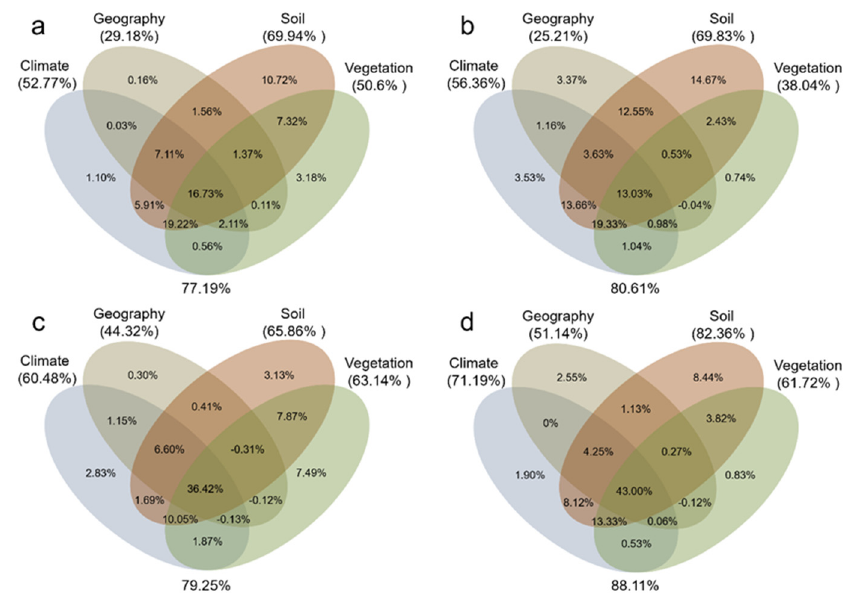
Figure 9. The relative contribution of environmental factors to the explanation of SAN and SAP (%): ( a – d ) are Venn diagrams of the relative contribution of four categories of environmental factors (climate, geography, soil, and vegetation) to SAN steppe , SAP steppe , SAN meadow , and SAP meadow .